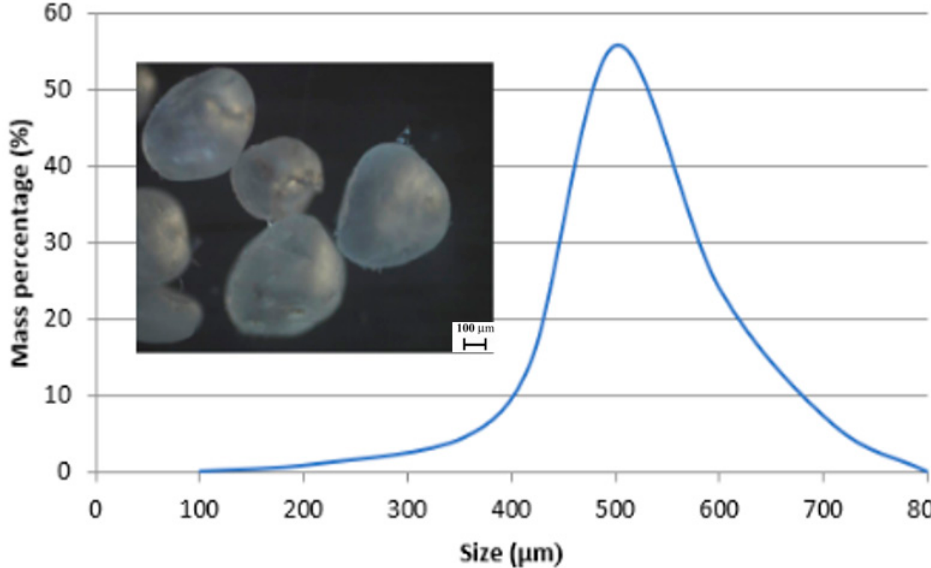
Figure 2. Size distribution of sand particles.